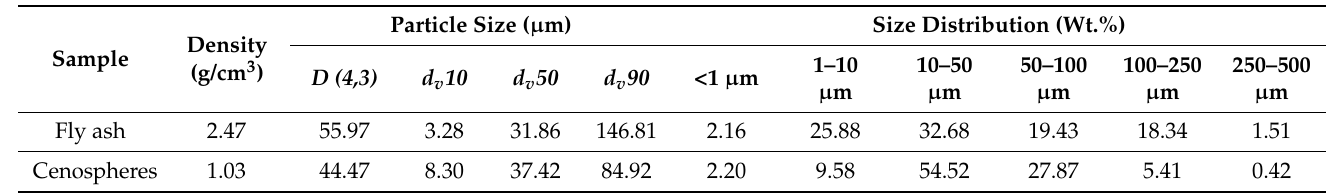
Table 1. Density, average particle size and size distribution of fly ash and cenospheres.